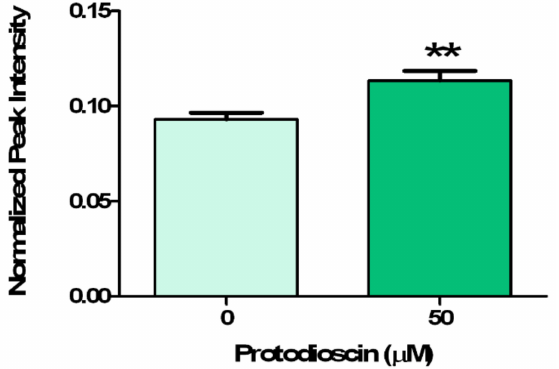
Figure 6. Relative quantification of IAA. Data are expressed as the average of the internal standard normalized intensity ± SE. Statistical significance of the data was evaluated through a t -test with p ≤ 0.05: * ( p ≤ 0.05), ** ( p ≤ 0.01), *** ( p ≤ 0.001). N =